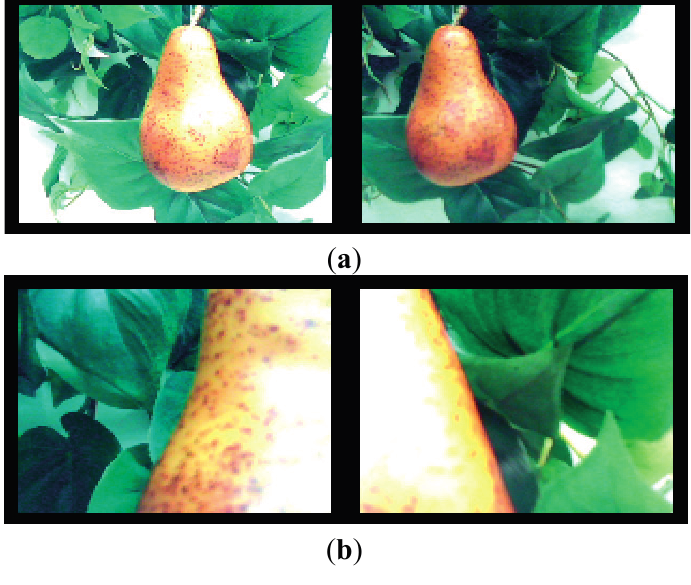
Figure 14. Example of stereovision images obtained while performing a fine approach to a fruit: ( a ) at the beginning of the approach; and ( b ) at the end of the